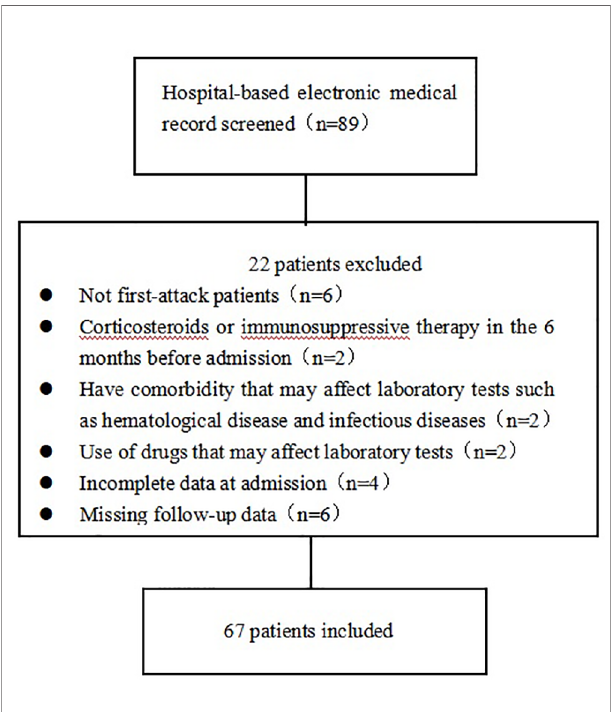
FIGURE 1 | Overview of the patient selection